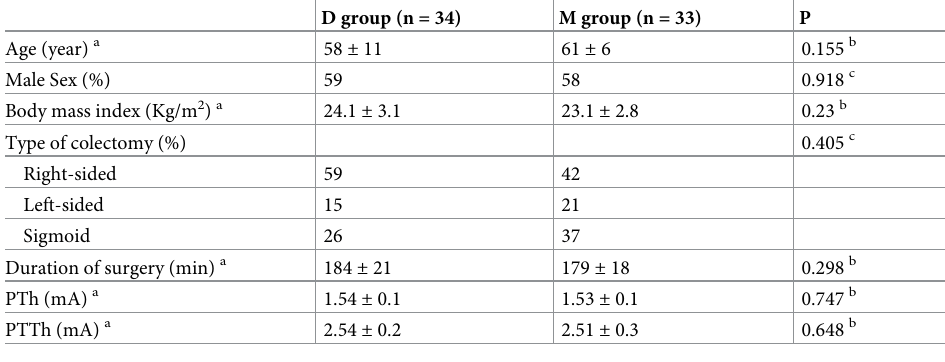
Table 1. Baseline characteristics and surgical aspects of the included patients in both the